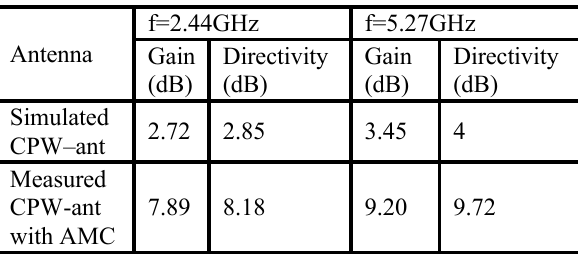
Table. 3: Simulated antenna